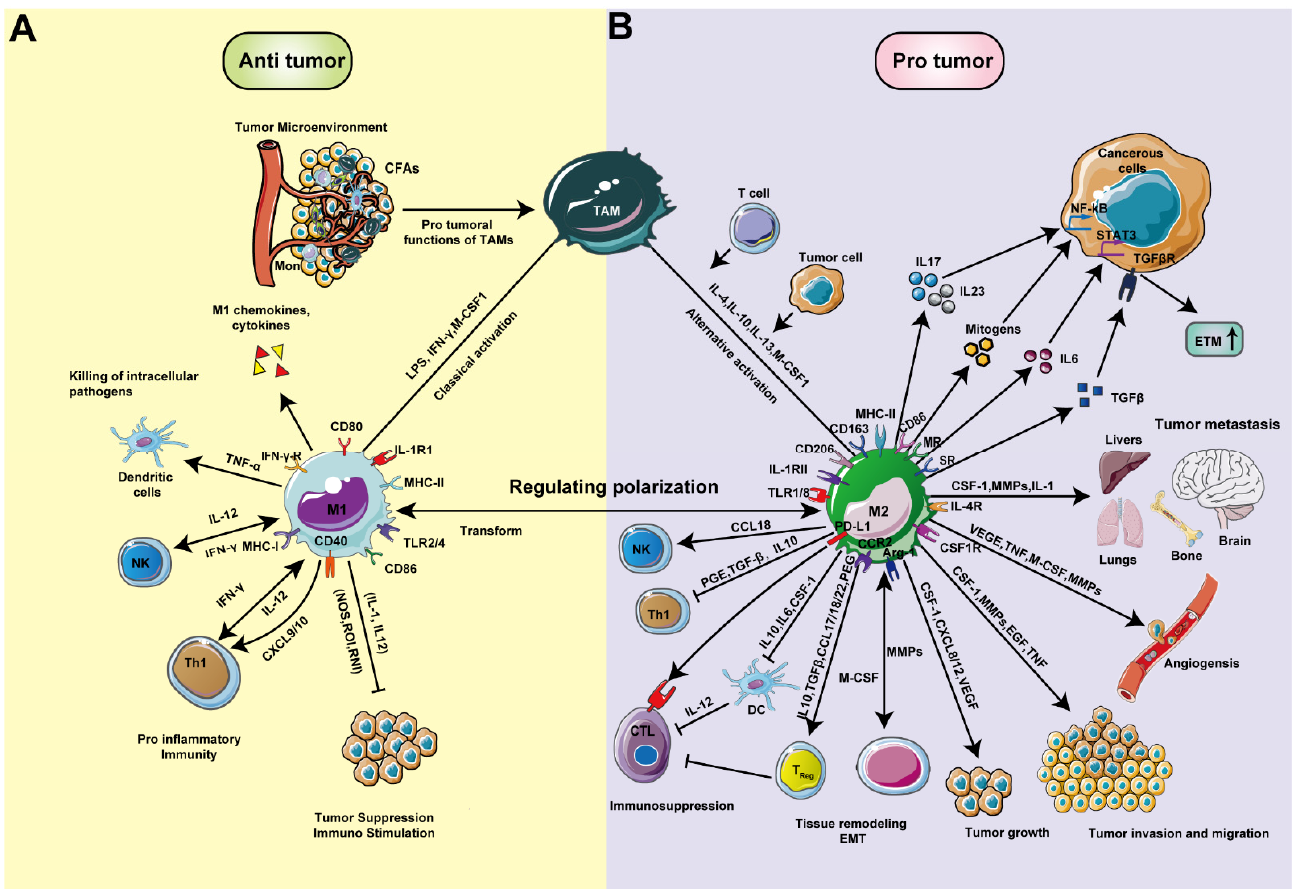
Figure 3. The role of tumor-associated macrophages (TAMs) in tumor progression. Macrophages are recruited into tumors under the action of chemokines and growth factors and gradually become TAMs. TAMs can be activated as ( A ) M1 macrophages with pro-inflammatory effects (antitumor) and ( B ) M2 macrophages with non-inflammatory properties (protumor). Among them, a variety of factors expressed and secreted by M2-like macrophages (such as VEGF, TNF- α , matrix metalloproteinase (MMP), CCL2 and CSF1) can induce tumor growth, migration, invasion, immunosuppression, treatment resistance and intravascular invasion. For example, M2 macrophages promote tumor migration and invasion through EGF, TNF, CSF-1 and MMPs; promote angiogenesis and tumor growth through the secretion of VEGF, MCSF, IL10 and TGF- β ; promote immunosuppression through the secretion of CCL17/18/22, CSF -1, IL-10, TGF- β and PEG; promote tumor metastasis by secreting CSF-1, IL-1 and MMPs; and induce cancer cell proliferation through NF- κ B or STAT3 signaling pathways. In contrast, the “classical activated” M1 macrophages are immune-stimulating, induce antitumor immunity and kill intracellular pathogens by the actions of IL-1, IL-6, IL-12, IL23, TNF- α , NOS, ROI and RNI. CTL, cytotoxic T lymphocytes; CAF, cancer-related fibroblasts; CSF1, colony-stimulating factor 1; TGF, transforming growth factor; IL, interleukin; TNF, tumor necrosis factor; MMP, matrix metalloproteinase; TLR, toll-type receptor; VEGF, vascular endothelial growth factor; LPS, lipopolysaccharide; NOS, inducible nitric oxide synthase; RNI, reactive nitrogen intermediates; and ROI, reactive oxygen intermediates. This figure was prepared using a template on the Servier